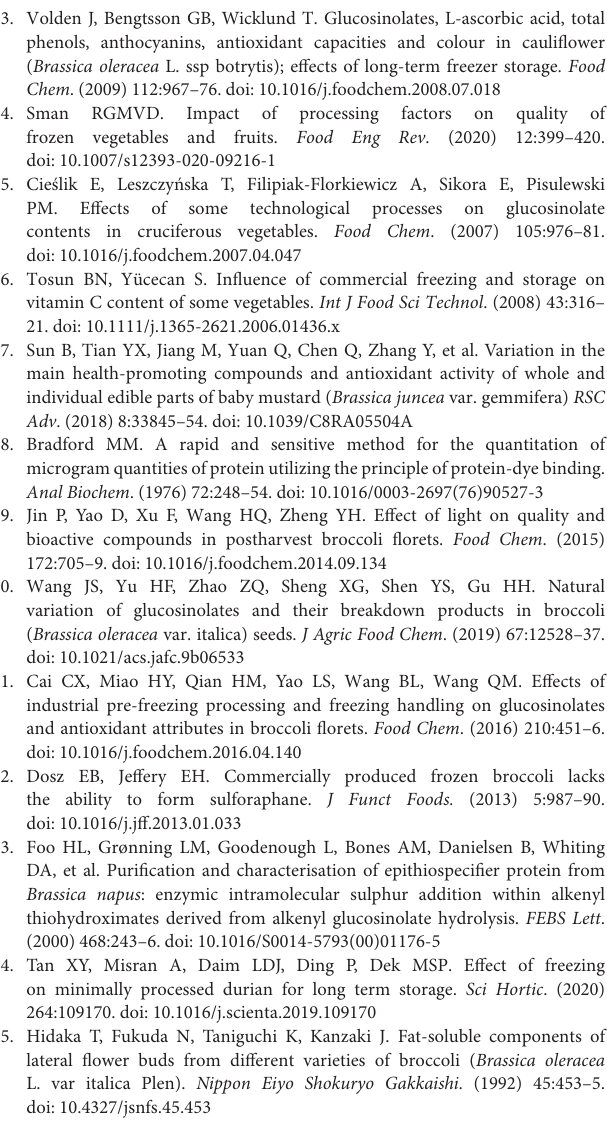
Supplementary Figure 1 | Evolution trend of 4-hydroxy glucobrassicin and total glucosinolate contents in baby mustard lateral buds during frozen storage at − 20 ◦ C. Unblanched represents no blanching before freezing; Blanched represents blanching before freezing. Values not sharing the same letter are significantly different at p <